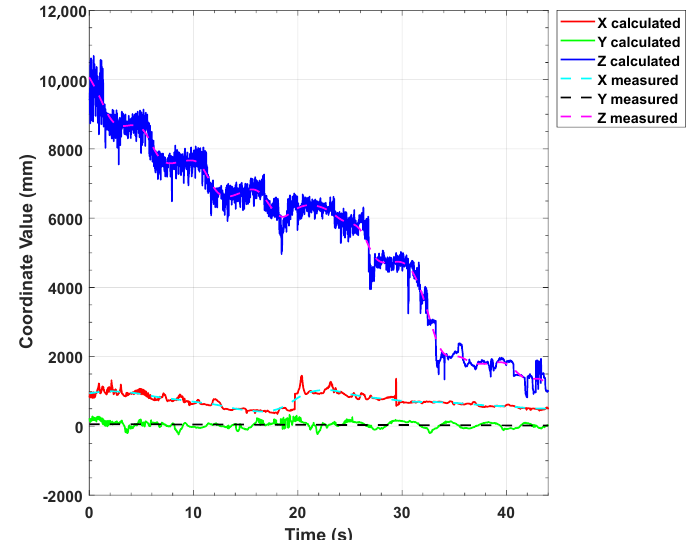
Figure 20. Dynamic positioning experiment results.